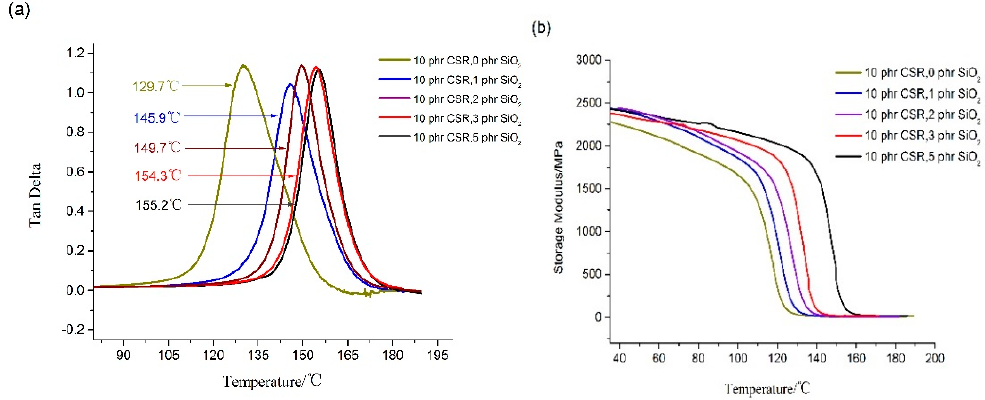
Figure 4. DMA test results of CSR / nano-SiO 2 modified epoxy resin: ( a ) Tan Delta curves of DMA test; ( b ) Storage Modulus curves of DMA test.